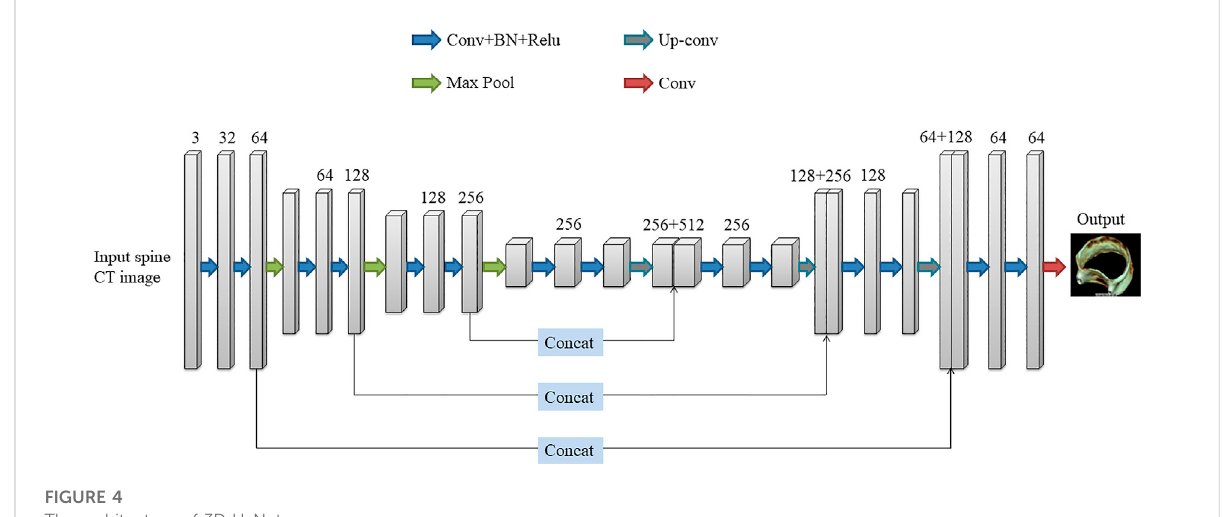
FIGURE 4 The architecture of 3D